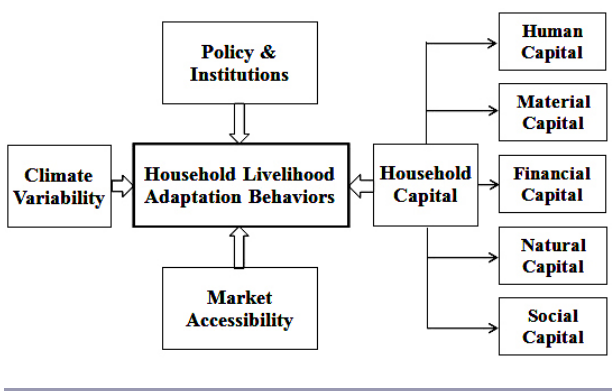
Fig. 2 . The framework for analyzing livelihood adaptation behaviors of the Tibetan herder households.